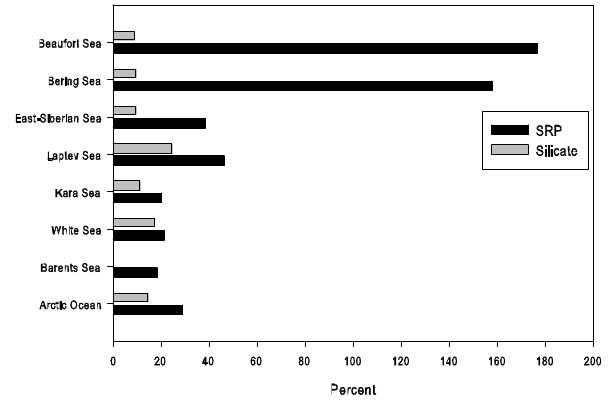
Fig. 8. Fraction of riverine SRP and silicate consumed by phyto- plankton in case all riverine nitrate is taken up. Note there were no silicate data for the Pechora River (Barents